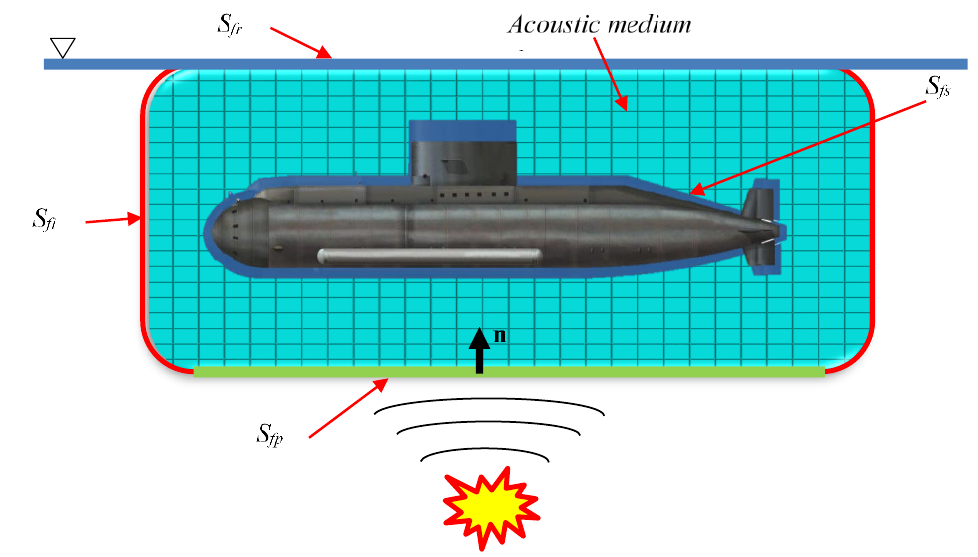
Figure 9. Acoustic medium subregions used in in computer aided engineering (CAE) programs.